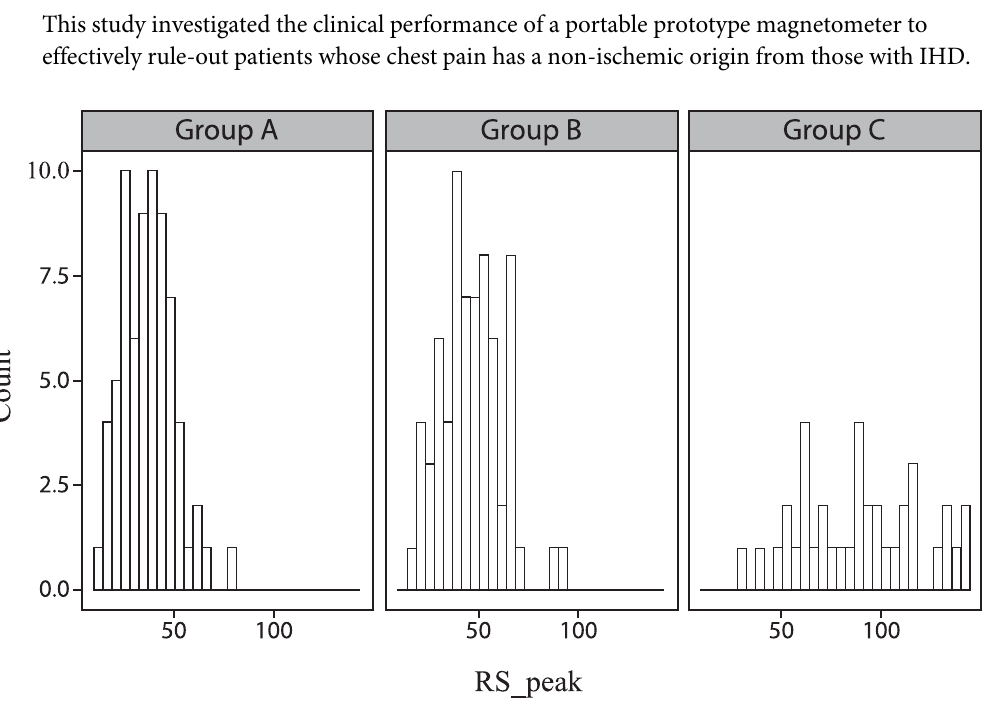
of 99.3%. A near perfect separation between the groups was achieved in Model 3 comparing patients with young healthy volunteers, with an AUC of 0.96 and specificity of 78.4% (sensitiv-